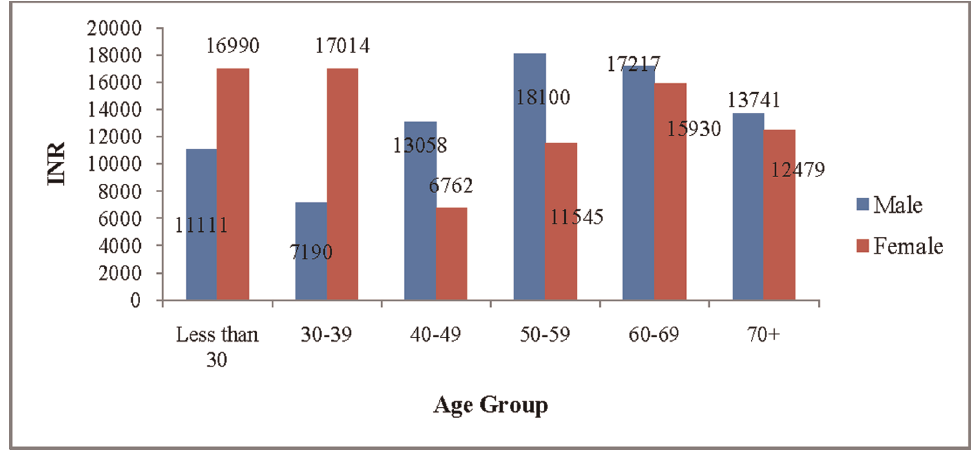
Figure 11. Mean cost of hospitalisation for CVDs by age and sex, India, 2004. doi:10.1371/journal.pone.0062134.g011 PLOS ONE |